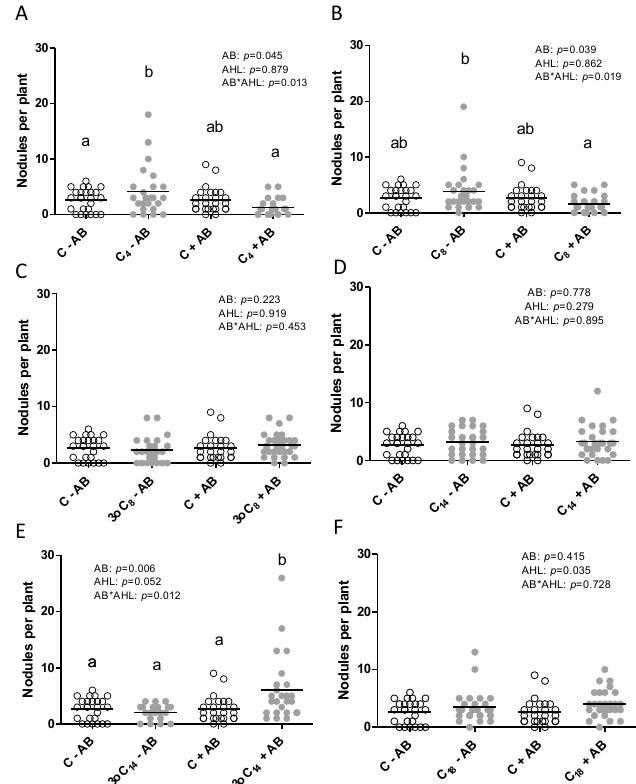
Figure 2. Nodule numbers of M. truncatula plants exposed to 1 µ M AHLs (acyl-homoserine lactone) and inoculated with rhizobia, measured at 21 days after inoculation. Plants were treated with (grey) or without (white) ( A ) C 4 -HSL, ( B ) C 8 -HSL, ( C ) 3-oxo-C 8 -HSL, ( D ) C 14 -HSL, ( E ) 3-oxo-C 14 -HSL, or ( F ) C 18 -HSL. The control treatments (‘C’) included the same dilution of the solvent as the AHL treatments. Di ff erent letters indicate significant di ff erences between the treatments when the interaction is significant (Restricted Maximum Likelihood test p < 0.05). No post hoc test when the interaction is not significant. AB: antibiotic treatment.